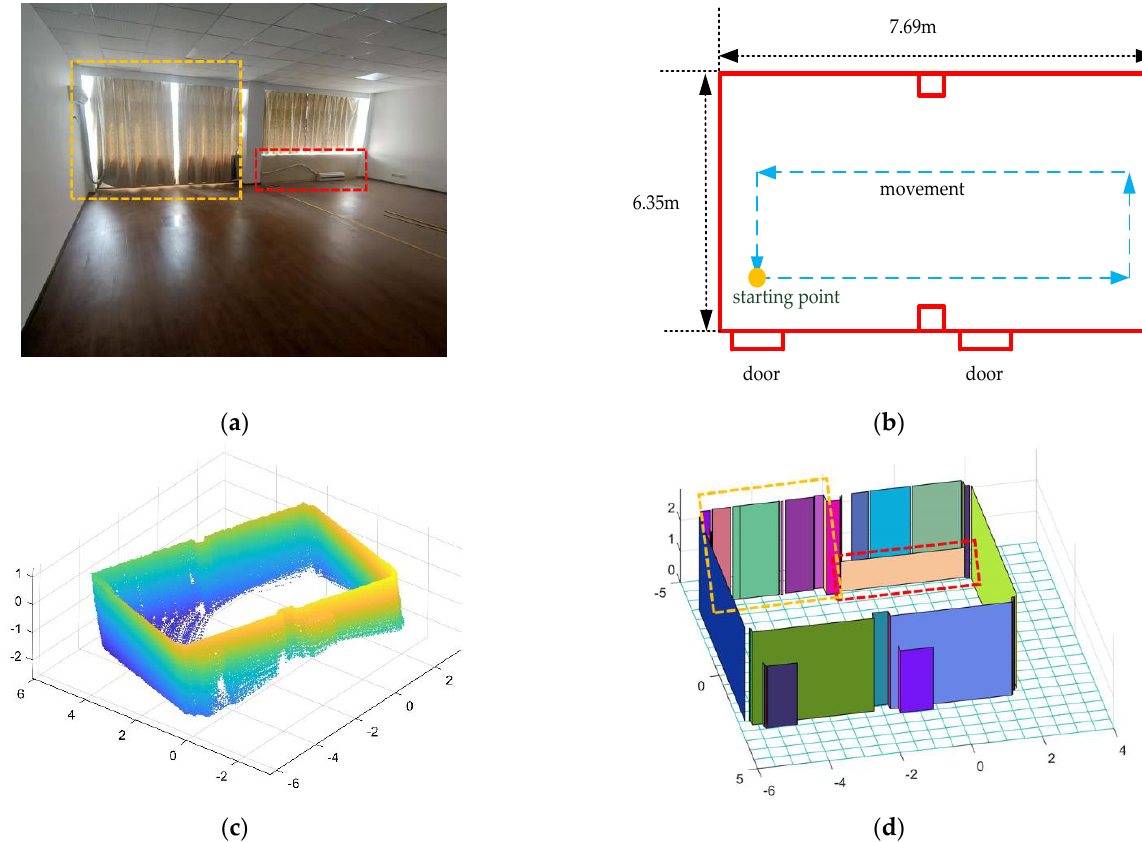
Figure 22. The resulting presentation of scene 1: ( a ) photo of the real scene; ( b ) the two-dimensional plane of the scene; we measured the dimensions of the room and marked the starting point and trajectory; ( c ) point cloud data after removing the ceiling; ( d ) the result of the reconstruction of the interior structure, and each color represents a plane.